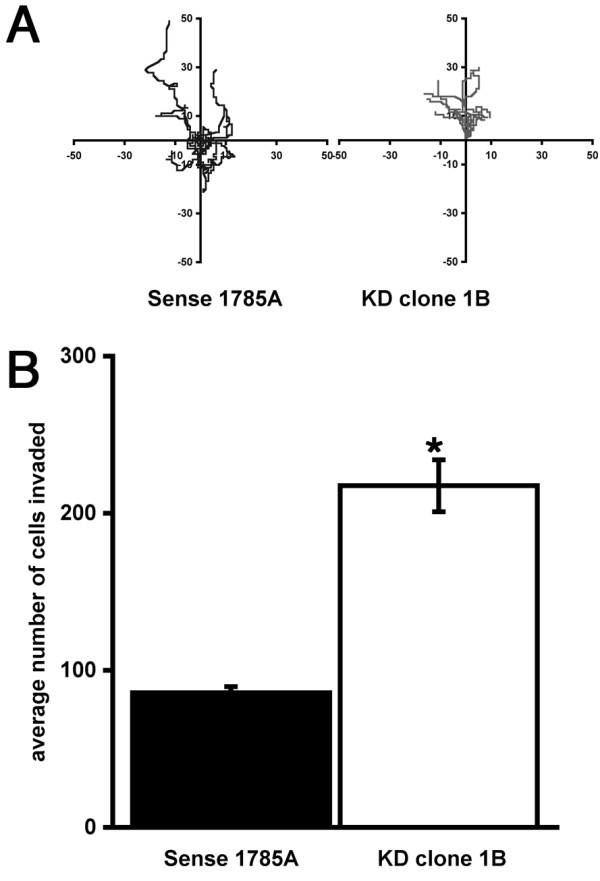
SM22α depletion results in increased cell migration/invasion. Despite a reduction in cell velocity REF52 cells depleted for SM22α were able to respond to a serum gradient in Dunn chemotaxis chamber assays (A). However, in invasion assays in Matrigel-coated Boyden chamber assays SM22 depleted cells exhibited a significantly enhanced capacity to invade (B; mean ± SEM 3 independent experiments, * p < 0.01 compared to sense control).